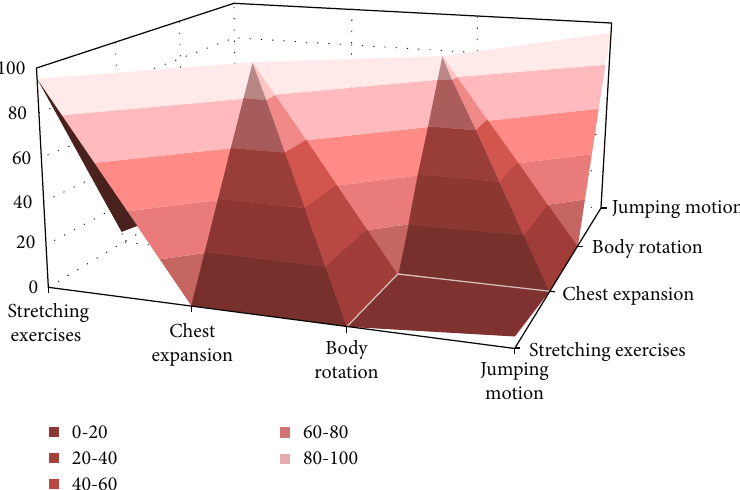
Figure 10: Confusion matrix for the UTKinect dataset test